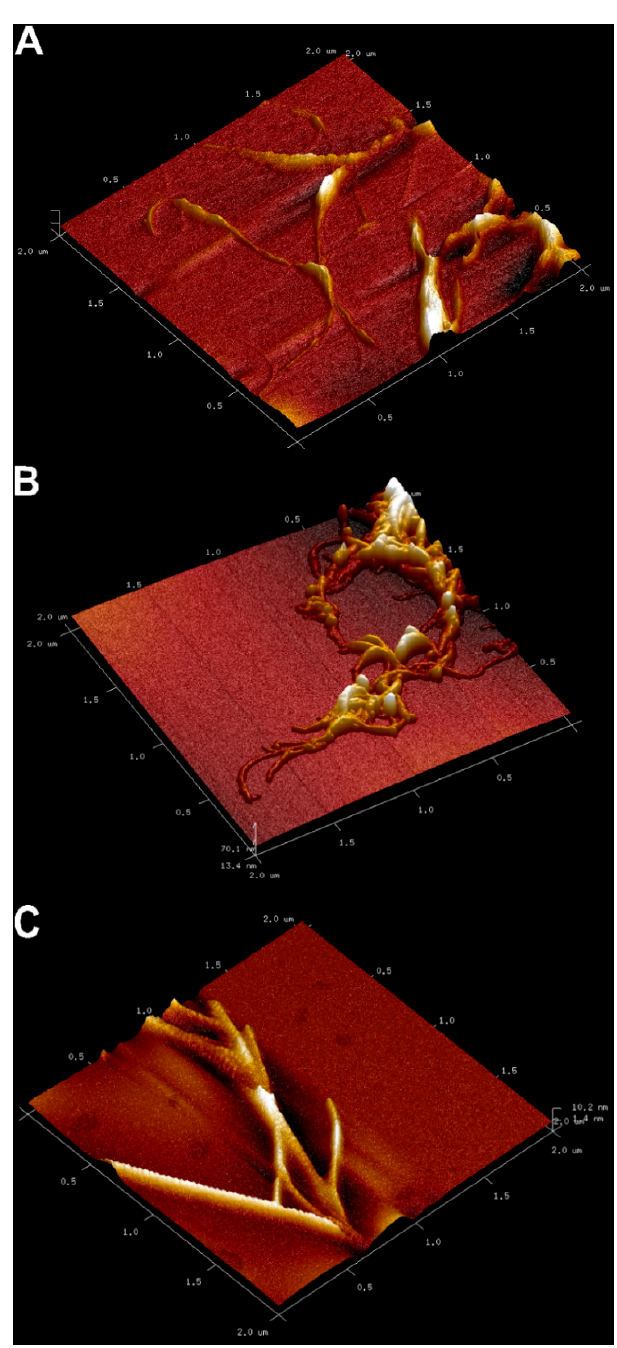
Figure 3. Atomic force microscopy (AFM) images of the prepared MW-CNTCPEs: ( A ) 15% MWCNT-CPE; ( B ) 25% MWCNT-CPE; ( C ) 35% MWCNT-CPE.